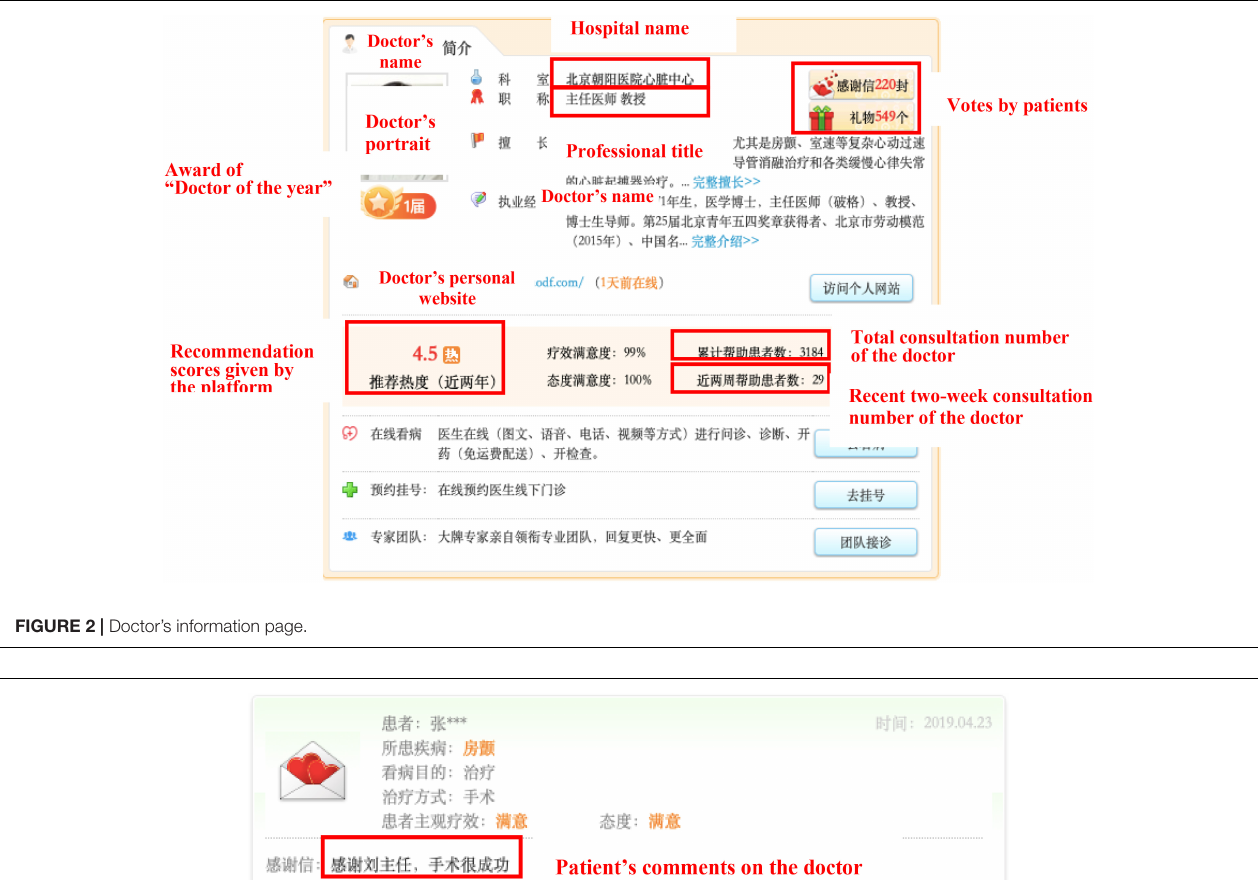
FIGURE 3 | A patient’s comment